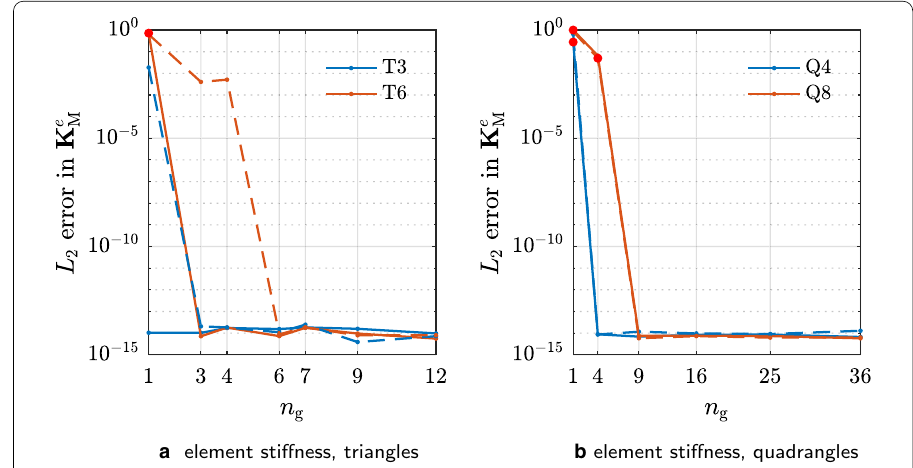
Fig. 2 L 2 errors of a single element stiffness matrix for triangular ( a ) and quadrilateral ( b ) elements as a function of the number of Gauss integration points. The accuracy is measured relative to the stiffness matrix obtained for the maximum number of integration points used ( n g = 13 for triangles and n g = 49 for quadrilaterals). Solid lines correspond to K e 00 and dashed lines to K e 11 sub-matrices of K e M in Eq. (21), whereas K e 01 = ( K e 10 ) T = 0 ; elements from Table 1 are used. Configuration of elements correspond to the reference undeformed state (microstructure with a square stacking of holes used, i.e., n = 1). Integration